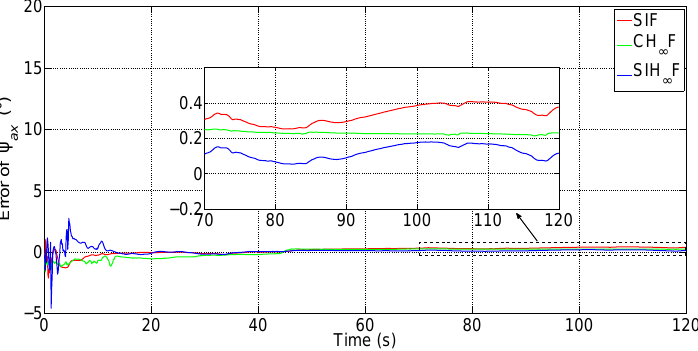
Figure 15. Error of ψ ax (the subfigure is the magnification of the estimation result during 70 s–120 s).